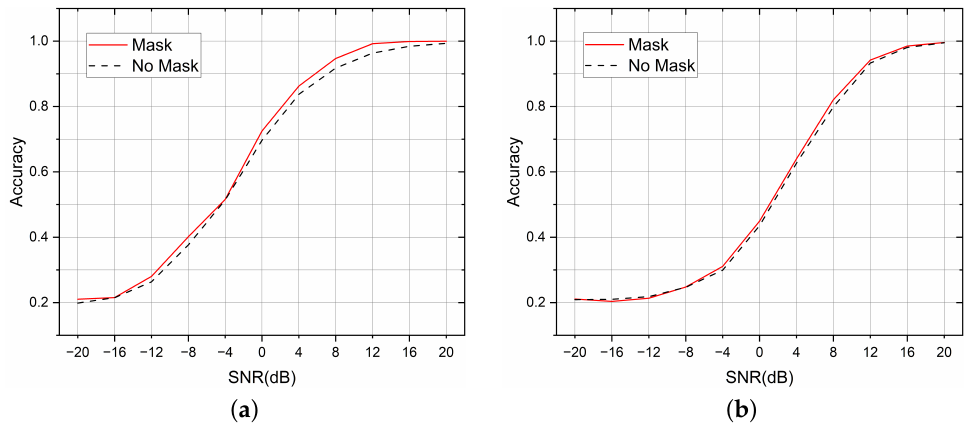
Figure 8. Adding a mask between the two task headers improves the performance on both tasks. ( a ) Comparison of the mask effects in the AMC tasks. ( b ) Comparison of the mask effects in the SEI